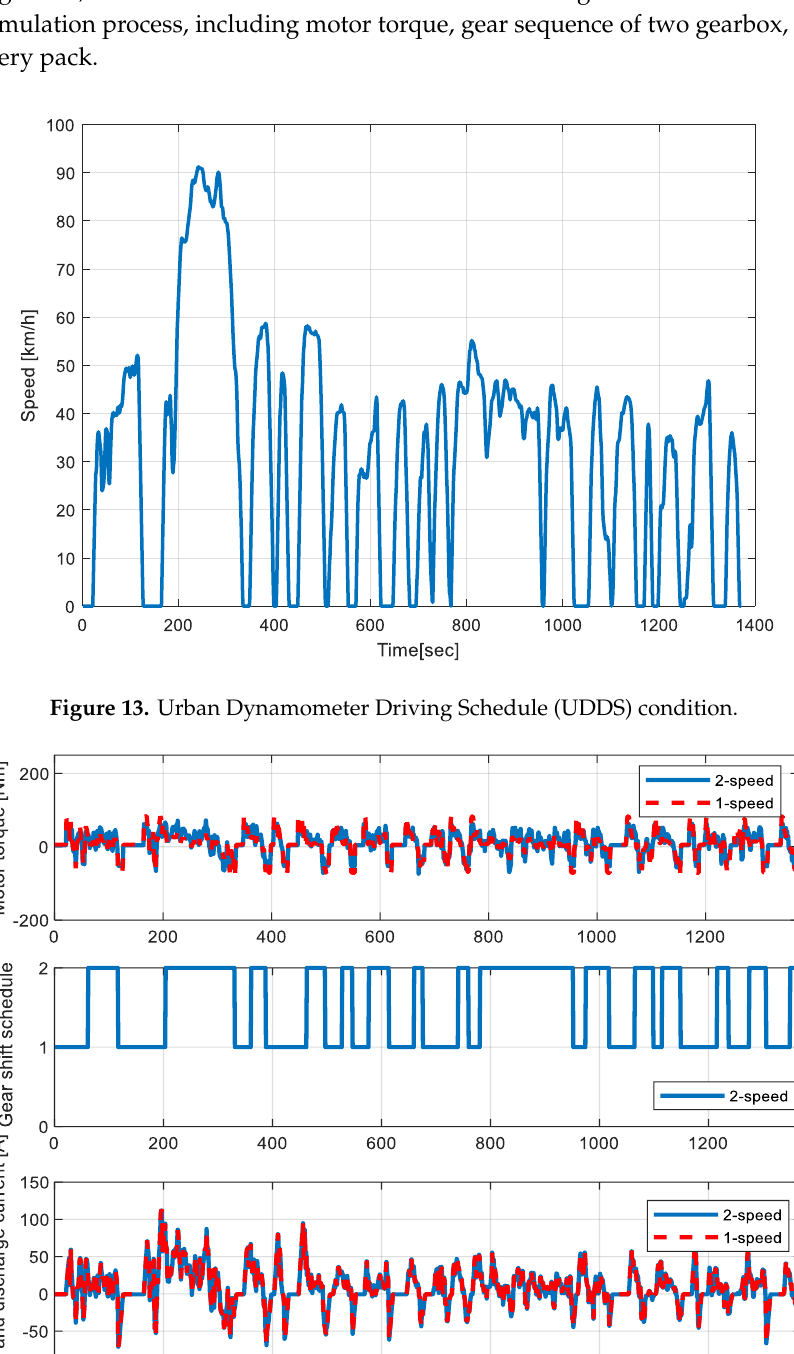
Figure 12. Simulation results of battery capacity loss percentage and energy consumption under NEDC conditions.